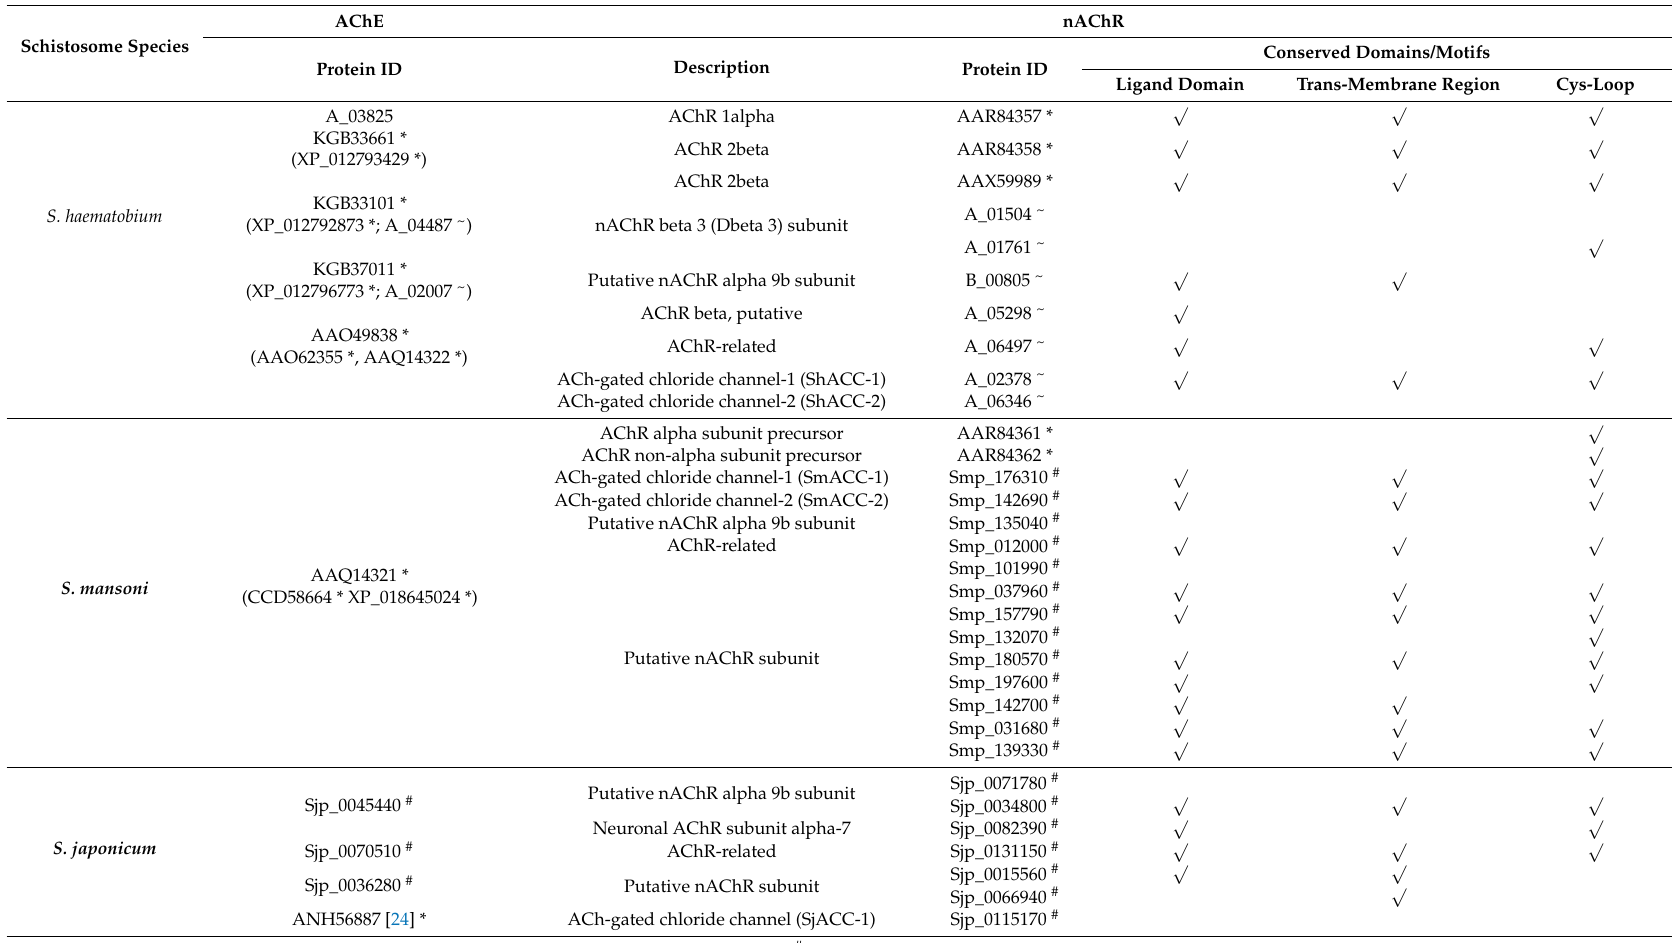
Table 1. AChEs and nAChRs identified in S. haematobium , S. mansoni and S. japonicum